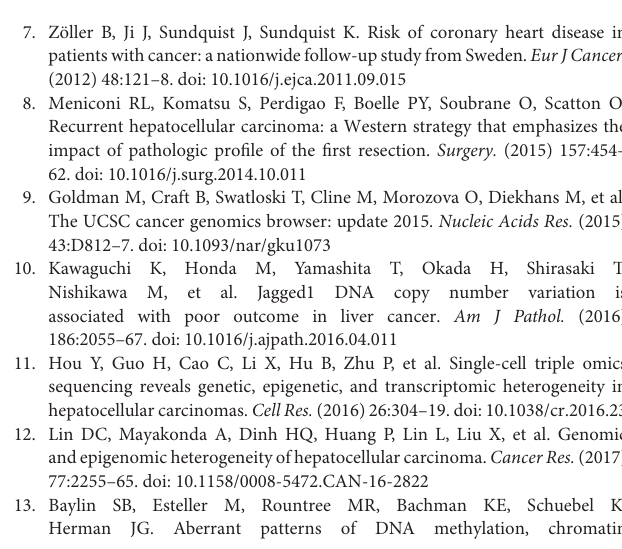
Supplementary Table 1 | 9161 CNVCor genes for liver cancer. Supplementary Table 2 | 6181 METCor genes for liver